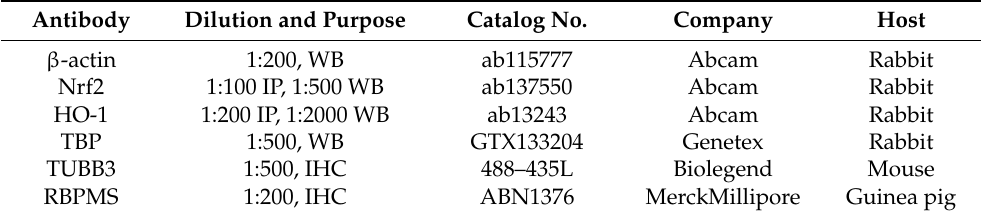
Table 1. List of antibodies used for immunostaining, immunoprecipitation, and Western